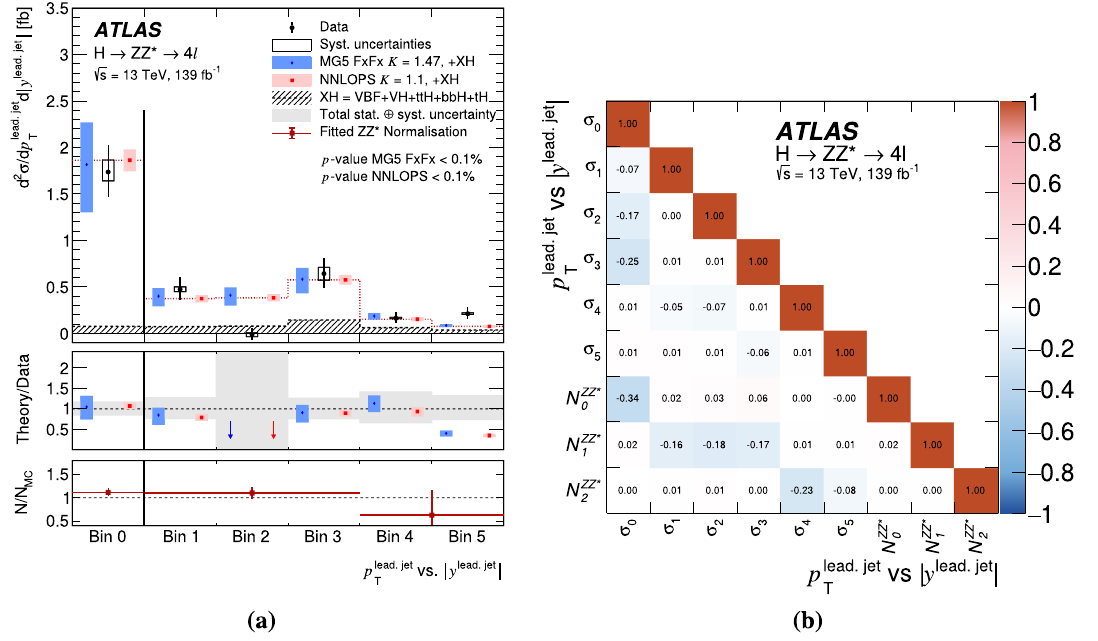
Fig. 38 a Double differential fiducial cross section for the trans- verse momentum of the leading jet vs. the rapidity of the lead- . jet ing jet, p lead vs. | y lead . jet | , and b the corresponding correlation T